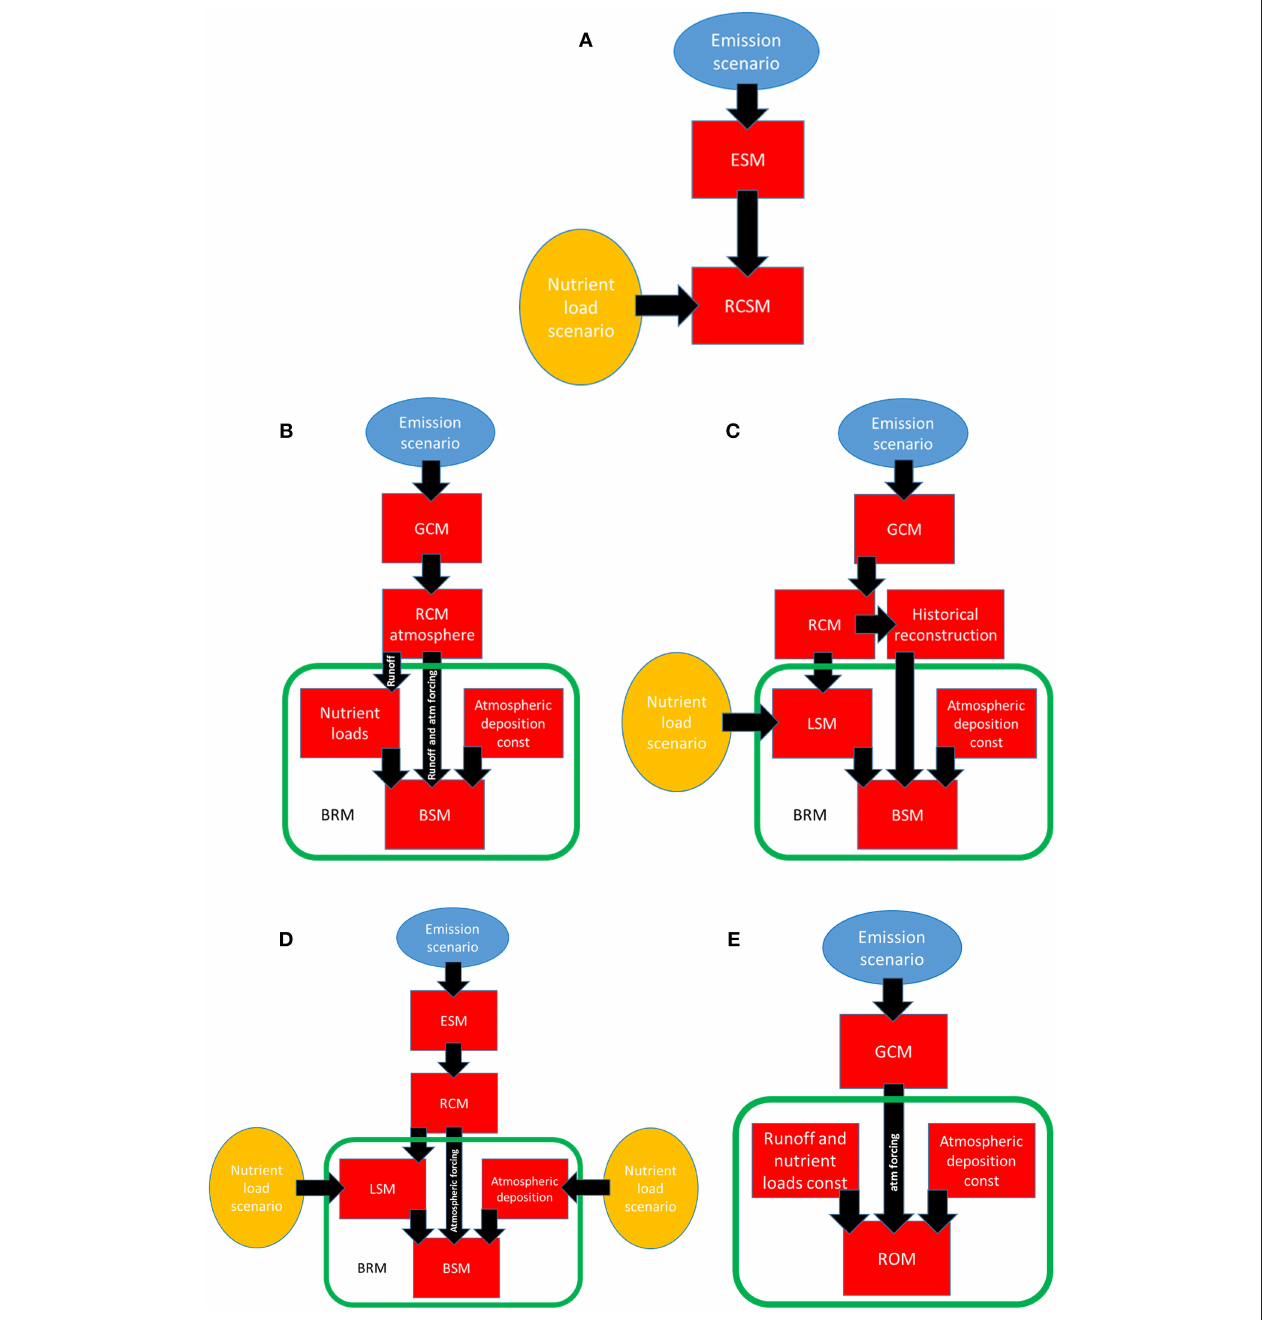
FIGURE 2 | (A) Hierarchy of models in the dynamical downscaling approach (ESM, Earth System Model; RCSM, Regional Climate System Model including atmosphere, sea ice, ocean, land surface and terrestrial vegetation, atmospheric chemistry, marine biogeochemistry, food web, fishery). (B) Hierarchy of models in the dynamical downscaling approach used, e.g., by Neumann (2010) (GCM, General Circulation Model or Global Climate Model; RCM, Regional Climate Model, i.e., a regional atmosphere model; BSM, Baltic Sea Model; BRM, Baltic Region Model including a BSM and data sets for riverine nutrient loads calculated from the product of river runoff and climatological river nutrient concentration and atmospheric deposition). (C) Hierarchy of models in the dynamical downscaling approach used, e.g., by Meier et al. (2011a). Monthly mean changes in atmospheric surface fields were added to a historical reconstruction that forces a Baltic Sea model (LSM, Land Surface Model; BRM, Baltic Region Model including a BSM, LSM, and data sets for atmospheric deposition). (D) Hierarchy of models in the dynamical downscaling approach used, e.g., by Saraiva et al. (2018). (E) Hierarchy of models in the dynamical downscaling approach used, e.g., by Holt et al. (2016) (ROM, Regional Ocean Model for the Black Sea, Barents Sea, North Sea and Baltic Sea, and Northwest European Continental Shelf).